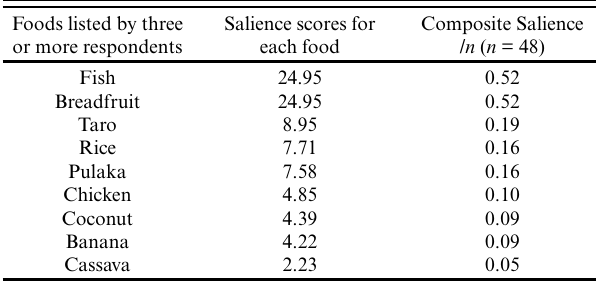
Table 4. Freelisting results for food preference (“What are your favorite foods?”)